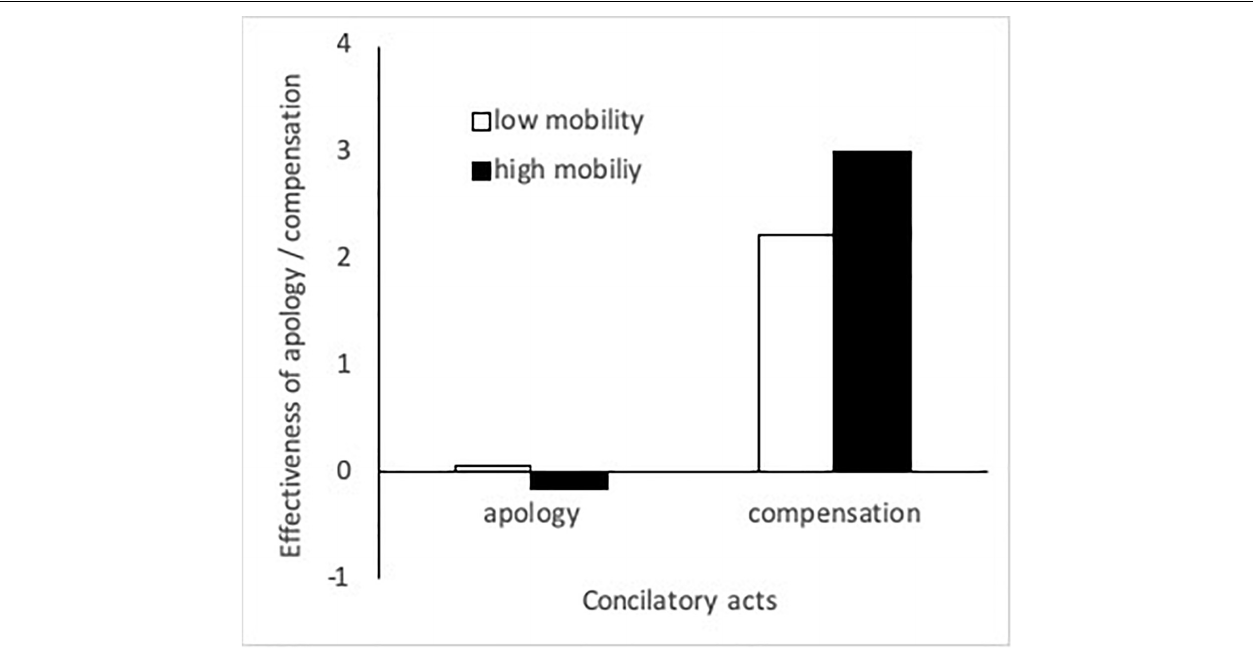
FIGURE 3 | The effectiveness of apology and compensation on forgiveness in the high- and low-mobility conditions, after controlling for gender (Study 3). The scores were calculated by subtracting the estimated intercepts (i.e., did nothing) from the estimated values of forgiveness after each reconciliation behavior (i.e., apology or compensation). The estimated values were calculated by entering the average score (0.61) into each gender term.